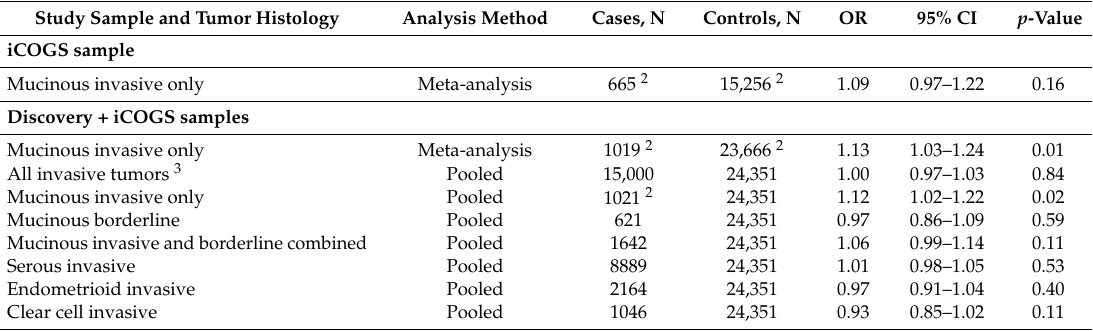
Table 1. Associations 1 between rs495139 and ovarian carcinoma among European subjects.